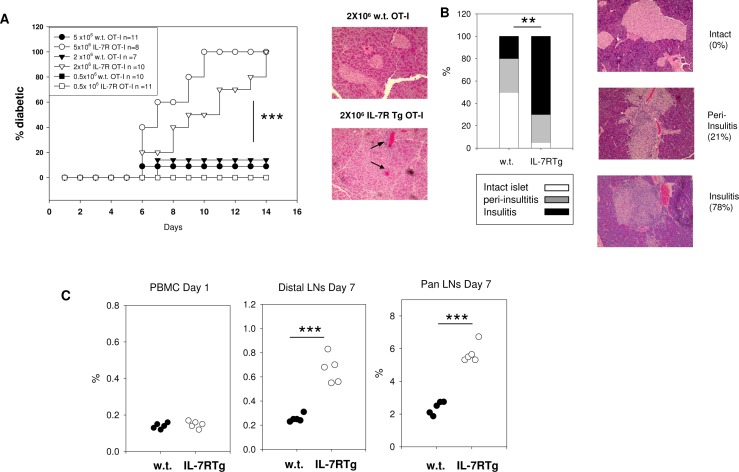
Forced expression of IL-7R enhances OT-I T cell mediated diabetes.A: Various numbers (5x 106, 2 x 106, 0.5 x106) of w.t. (closed symbol) or IL-7R Tg (open symbol) OT-I T cells were transferred into RIP-mOVA mice (n = 7–11 in each group). Left: Diabetes incidence in the recipients. IL-7R Tg vs. w.t in 5 x 106 group: p<0.001; IL-7R Tg vs. w.t in 2 x 106 group: p<0.001 (log-rank test). Right: Representative H&E staining of pancreata from mice that have received 2 x 106 OT-I cells. Note: in mice injected with IL-7R Tg OT-I T cells, most islets in the pancreas were destroyed (arrows). B: Left: summary of insulitis. 5 sections per pancreas and an average 10 islets per mouse were scored blindly for insulitis (n = 5 in each group). Right: representative H&E staining of pancreata used in insulitis scoring. The percentage of infiltrated area in the islet was quantified by Image J: intact islet = no infiltration, peri-insulitis = 0–30%, insulitis = 30%- 90%. C: 2 x106 purified OT-I T cells from w.t. or IL-7R Tg mice were transferred into RIP-mOVA mice (n = 5). The percentages of OT-I T cells recovered from the recipients are shown (left: PBMC (peripheral blood mononuclear cell) at day1, middle: distal LNs at day7, right: pancreatic draining LNs at day7). Total numbers of lymphocytes recovered from two groups and their viabilities were similar (distal LN: w.t (1.2 +/- 0.1 x 106) vs. IL7R Tg (1.4 +/-0.2 x 106, >90% viable), pancreatic draining LN: w.t. (1.2+/- 0.3 x 106) vs. IL7R Tg (1.3+/-0.1 x 106, >90% viable).